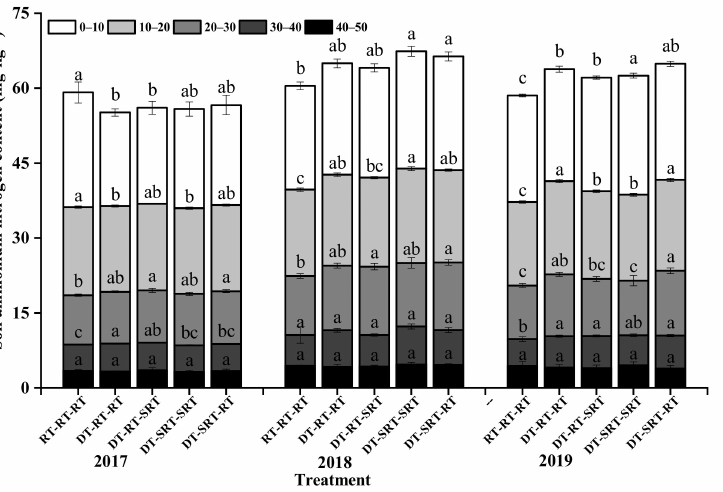
Figure 4. Soil ammonium nitrogen content in different soil layers under different treatments. Note: Different lowercase letters indicate significant differences between different treatments at the same soil layer ( p ≤ 0.05).